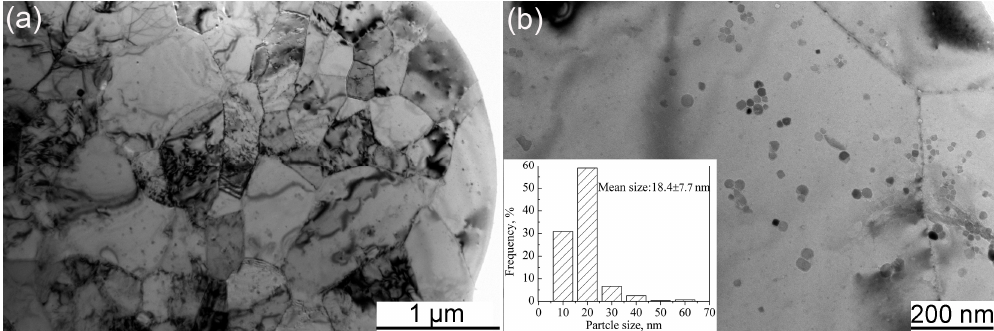
Figure 9. ( a ) TEM microstructure of the MX steel; ( b ) particles in the micro-sized grain.